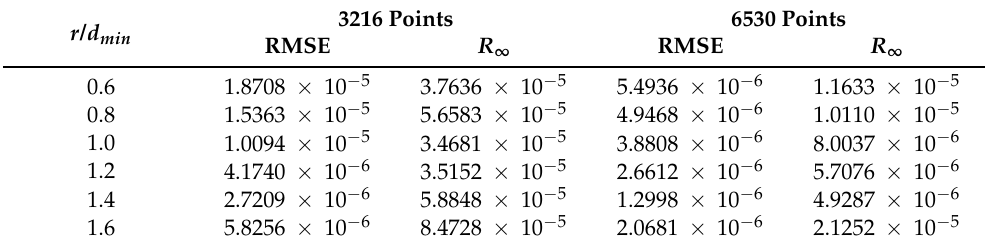
Table 7. Example No. 2—comparison of RMSE and R ∞ for different radii of virtual area.